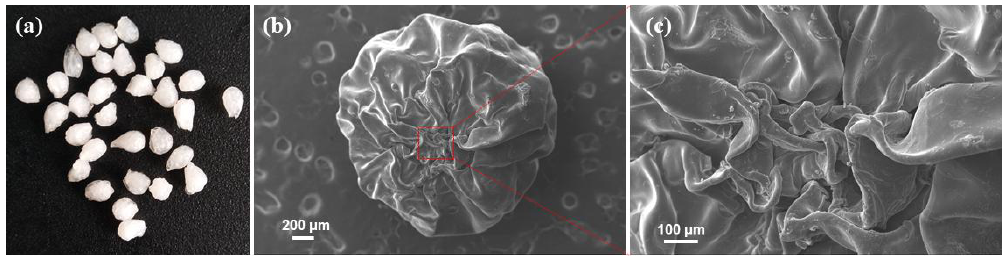
Figure 3. ( a ) Digital photo of Alg-Mel; ( b ) SEM image of Alg-Mel at low magnification; ( c ) SEM image